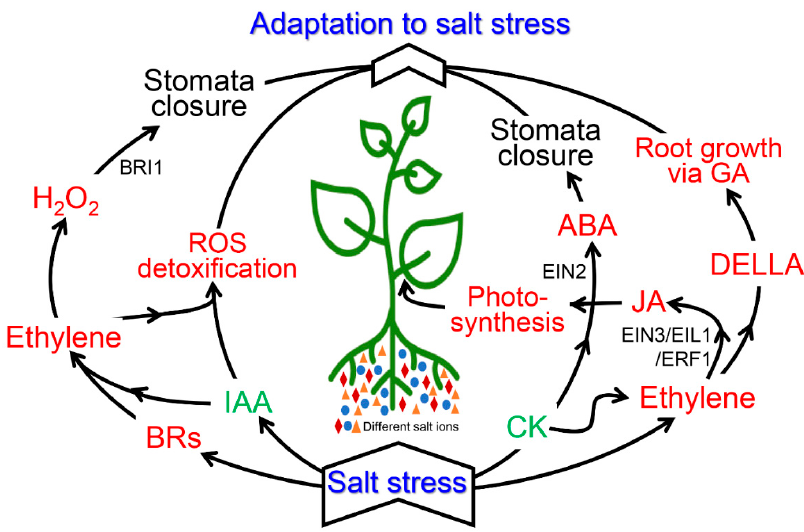
Figure 3. Schematic diagram of hormonal cross-talk under salinity stress. Details of the cross-talk are given in the text. Abbreviations used: BR: Brassinosteroids, IAA: Indole-acetic acid. CK: Cytokinin, ABA: Abscisic acid, GA: Gibberellin, JA: Jasmonic acid.